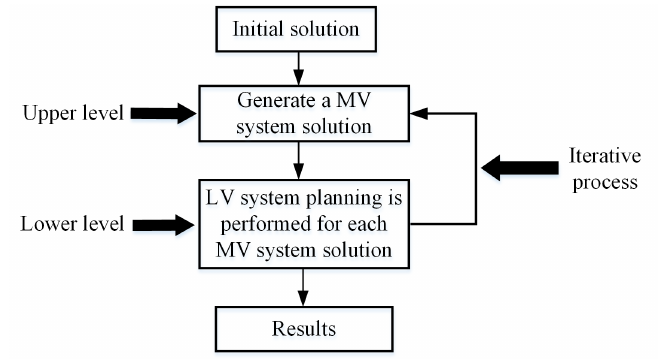
Figure 1. Decomposition